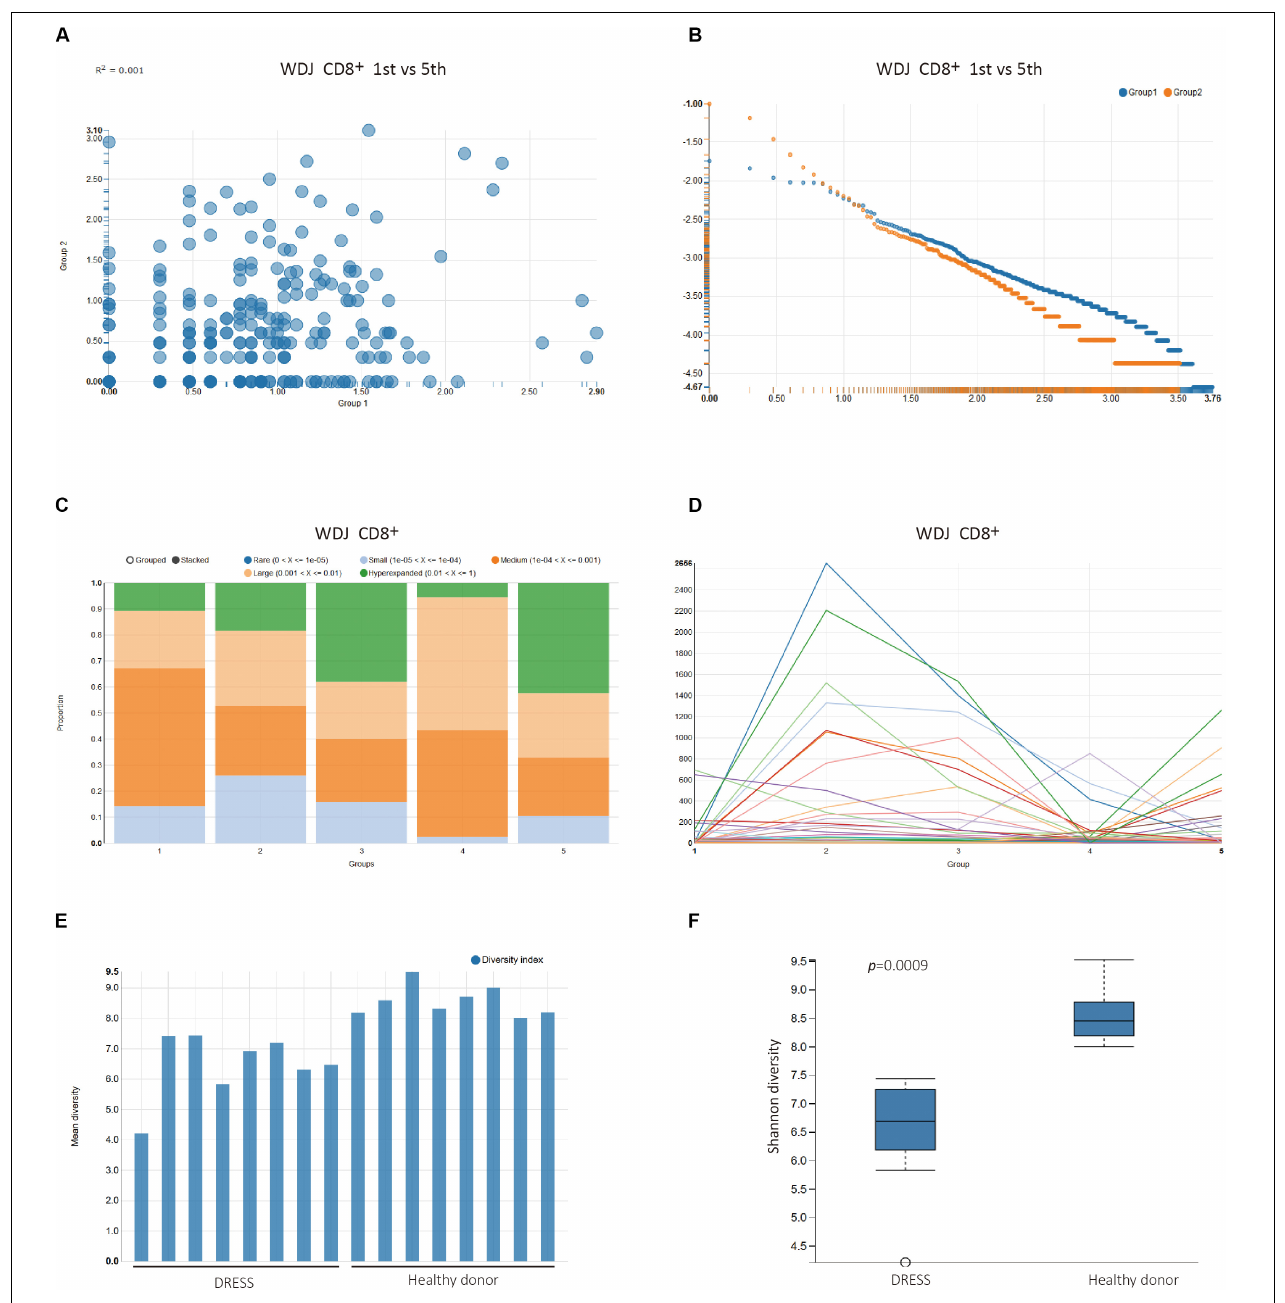
FIGURE 3 | Multi-time point sample analysis of patient WDJ. (A) Overlapping Clonotype Frequency plots between time point 1 (Group1) and time point 5 (Group 2). (B) Un-overlapping Clonotype Frequency plots of time point 1 (Group1) and time point 5 (Group 2). (C) Clonal space homeostasis visualization to help identify potential clonal expansion. The proportional distribution of the fourth timepoint TCR clonotypes differed from the third timepoint ( p < 0.0001, Chi-square test) and fifth timepoint ( p < 0.0001, Chi-square test). (D) Clonal tracking mapping the dominance of a given clone across all samples. Each line corresponds to a unique TCRB clonotype. As a general trend, it can be seen that a number of clones undergo clear expansion at the earlier timepoint (time2) before subsequently contracting (time4), a behavior consistent with memory T cell formation following the end of antigen exposure. (E) Bar plot of Shannon diversity index. Two groups, DRESS patients and healthy donors, of repertoires are selected and analyzed. (F) Box plot of the two